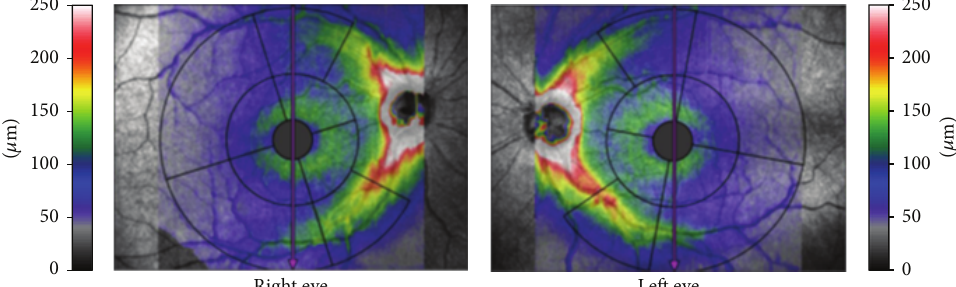
Right eye Left eye Figure 1: Measurement grids of OCT-HS100 Glaucoma 3D algorithm. The grids are centered on the fovea and rotated in alignment with the centre of the optic disc. Both foveal centre and optic disc centre are aligned on the same axis to account for the influence of anatomic variation in the nerve fiber layer bundles.